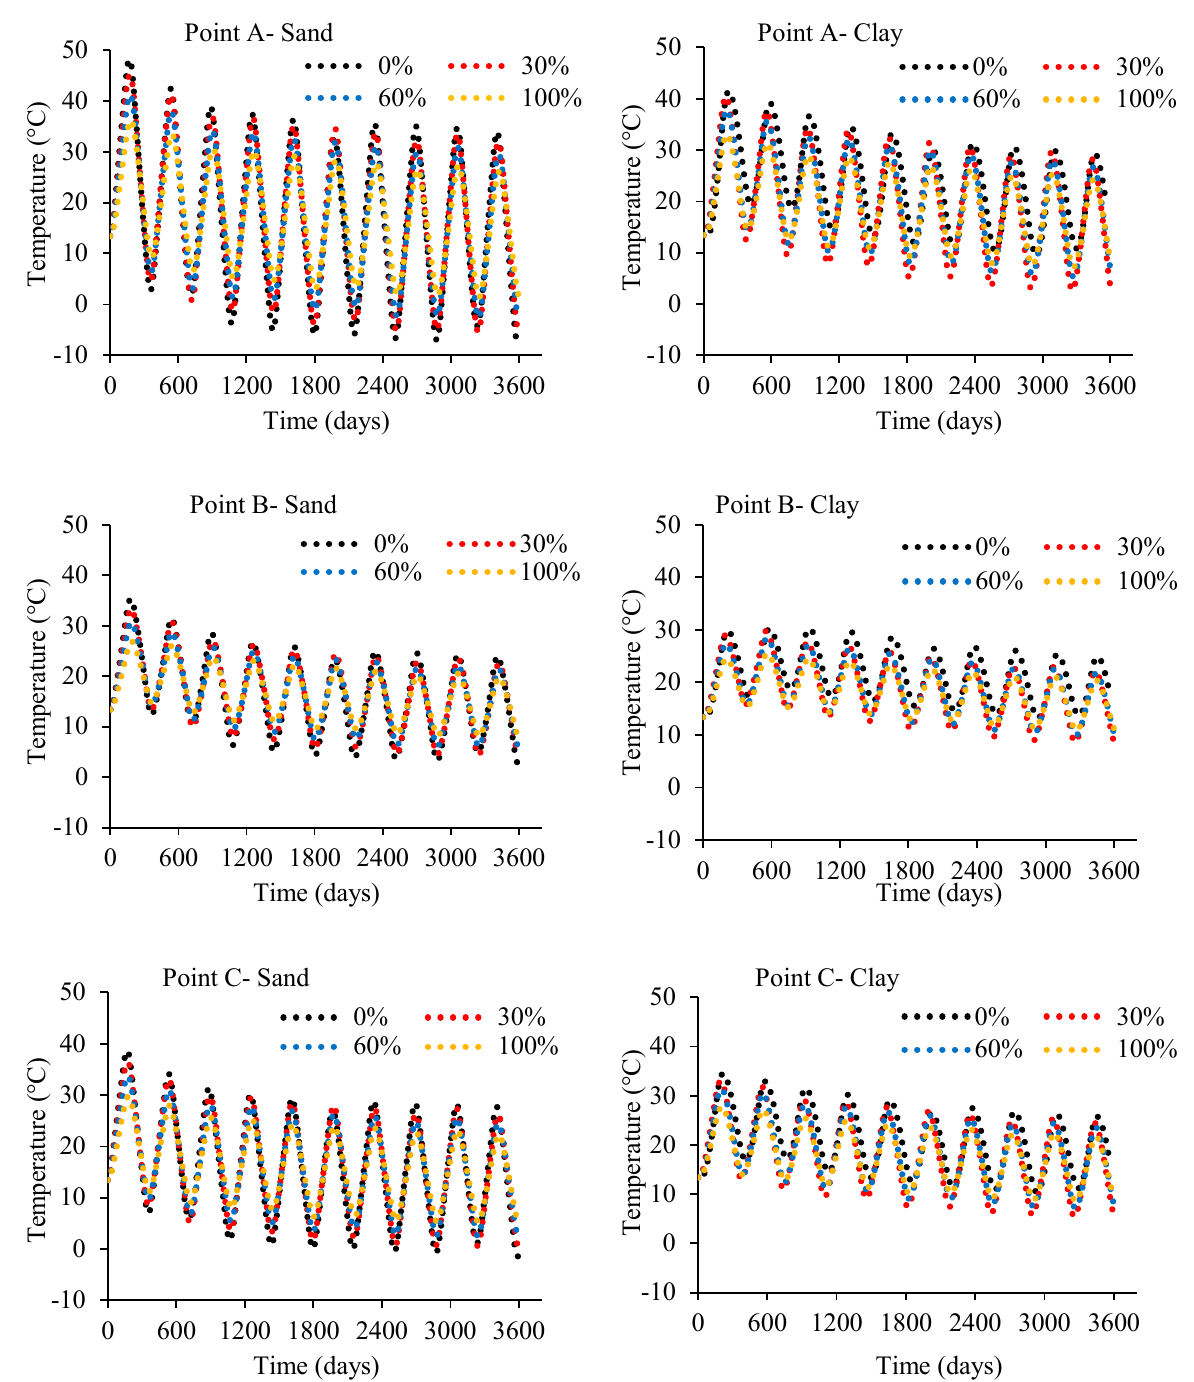
Figure 14. The results of the temperature evolution with time at points A, B, and C for the cyclic heating and cooling of alternate GEPs in the group .